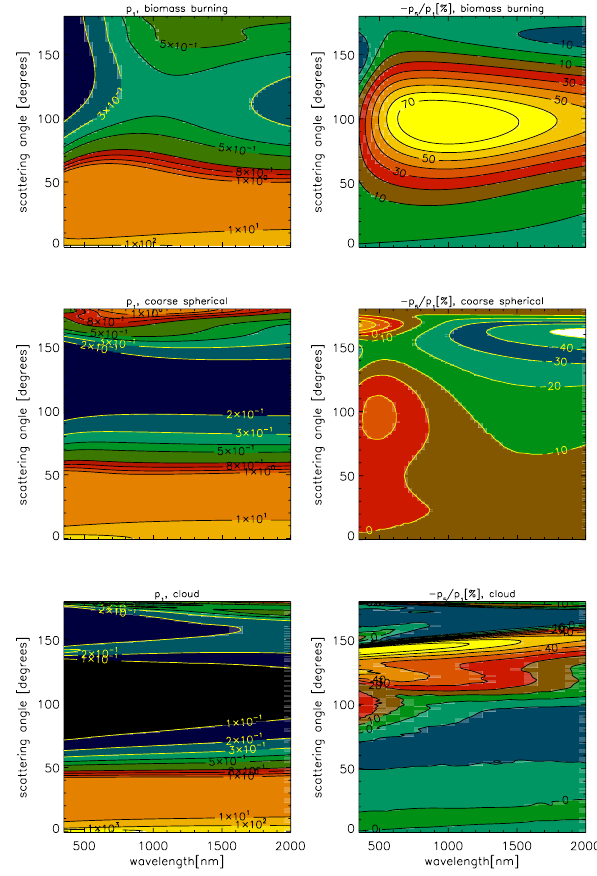
Fig. 1. Element p 1 (left panels) and signed degree of linear po- larization − p 5 /p 1 (right panels) of the scattering phase matrix as a function of wavelength and scattering angle for biomass burning aerosols (upper panels), coarse spherical aerosols (middle panels), and cloud particles (lower